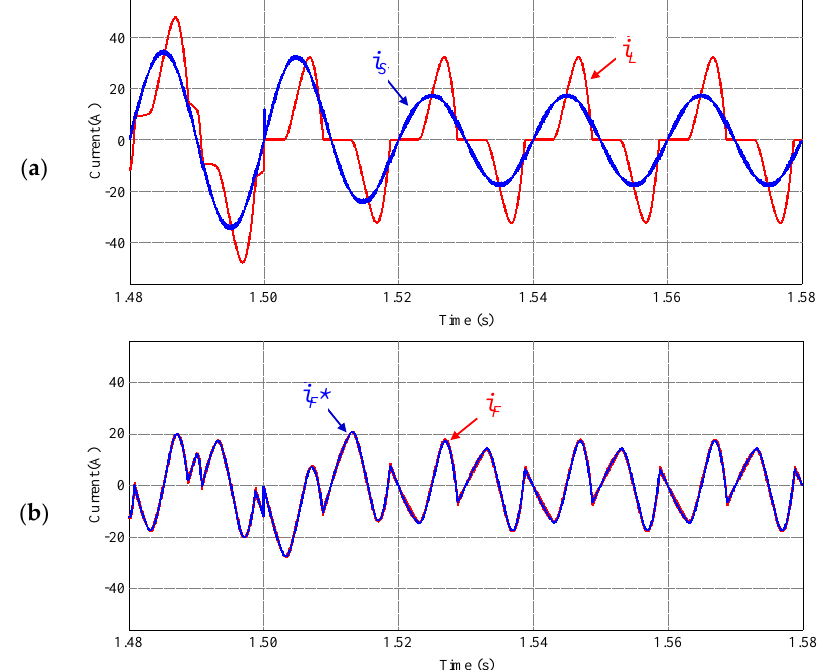
Figure 15. Transient analysis of the SAPF DC-link voltages ( v DC 1 and v DC 2 ) during the connection of a non-linear load. Energies 2018 , 11 , x